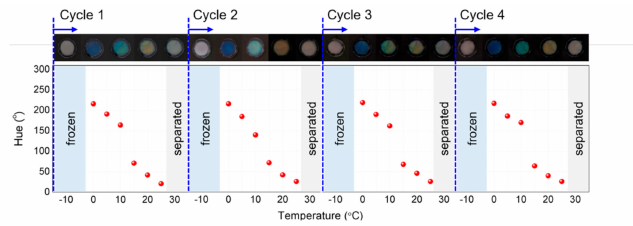
Figure 3. Repeatability and durability test of the HPC colorimetric